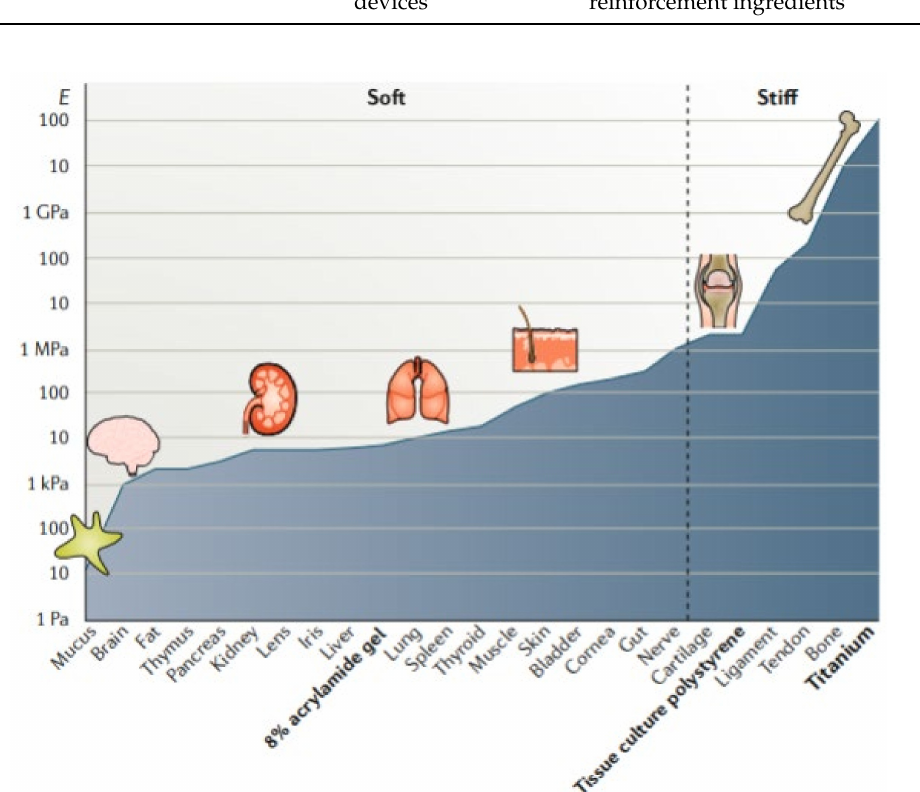
Figure 10. Crescent moduli of living tissues together with moduli of some TE materials. Tissues and materials are organized by increasing crescent moduli. Reproduced with permission from